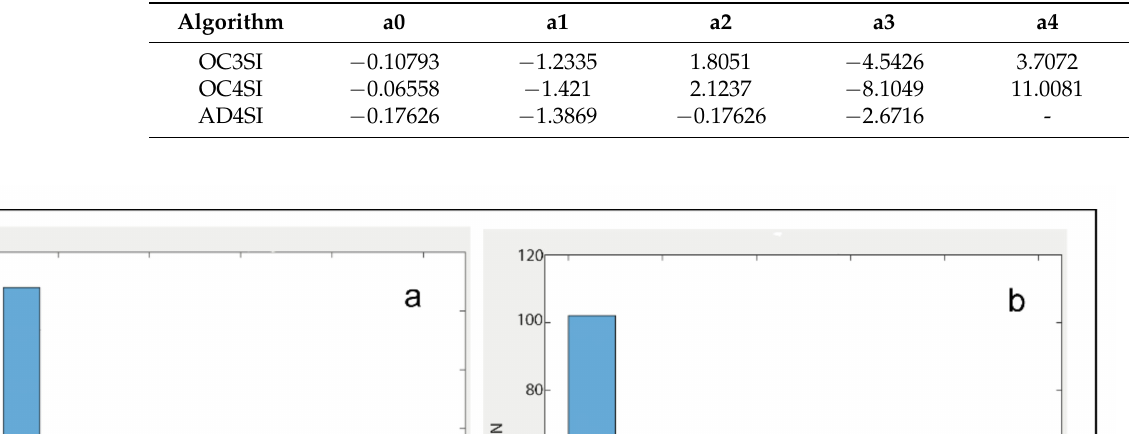
Figure 8. ( a ) Scatter plot of in-situ Chl- a versus AD4SI. ( b ) Same in logarithmic scale. The offshore and nearshore stations (Figure 1) are in blue and magenta colors, respectively. Table 2. The new coefficients of the OC3SI, OC4SI and AD4SI algorithms.